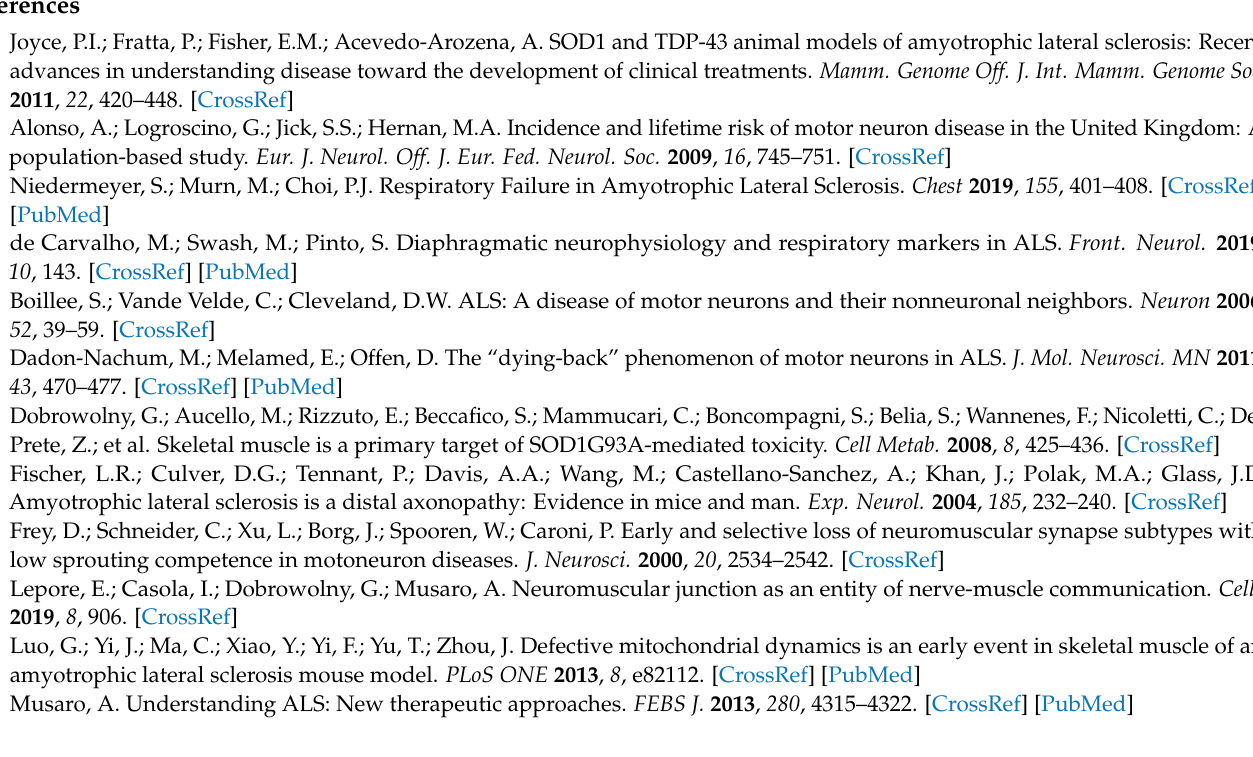
Supplementary Figure S2: Western blot results for MG53 in TA muscles derived from G93A and WT mice at the age of 2 months and 4 months, Supplementary Table S1: Demographics of human decedents, Supplementary Table S2: Biospecimen information for human